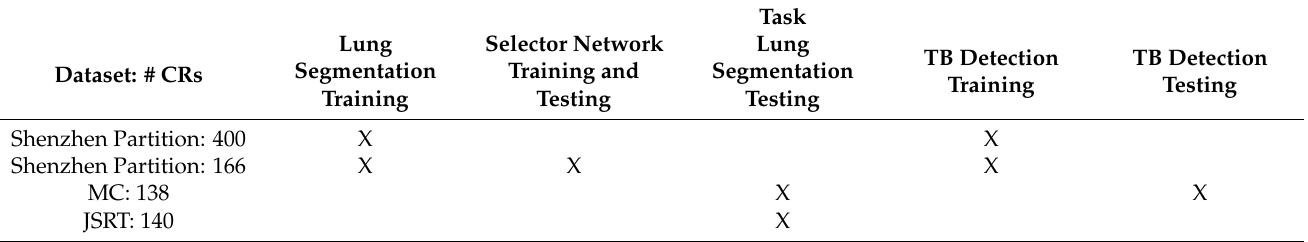
Table 2. List of datasets used for different algorithm tasks. Note that the training tasks were carried out with the Shenzhen data, while the other two independent datasets were used for testing